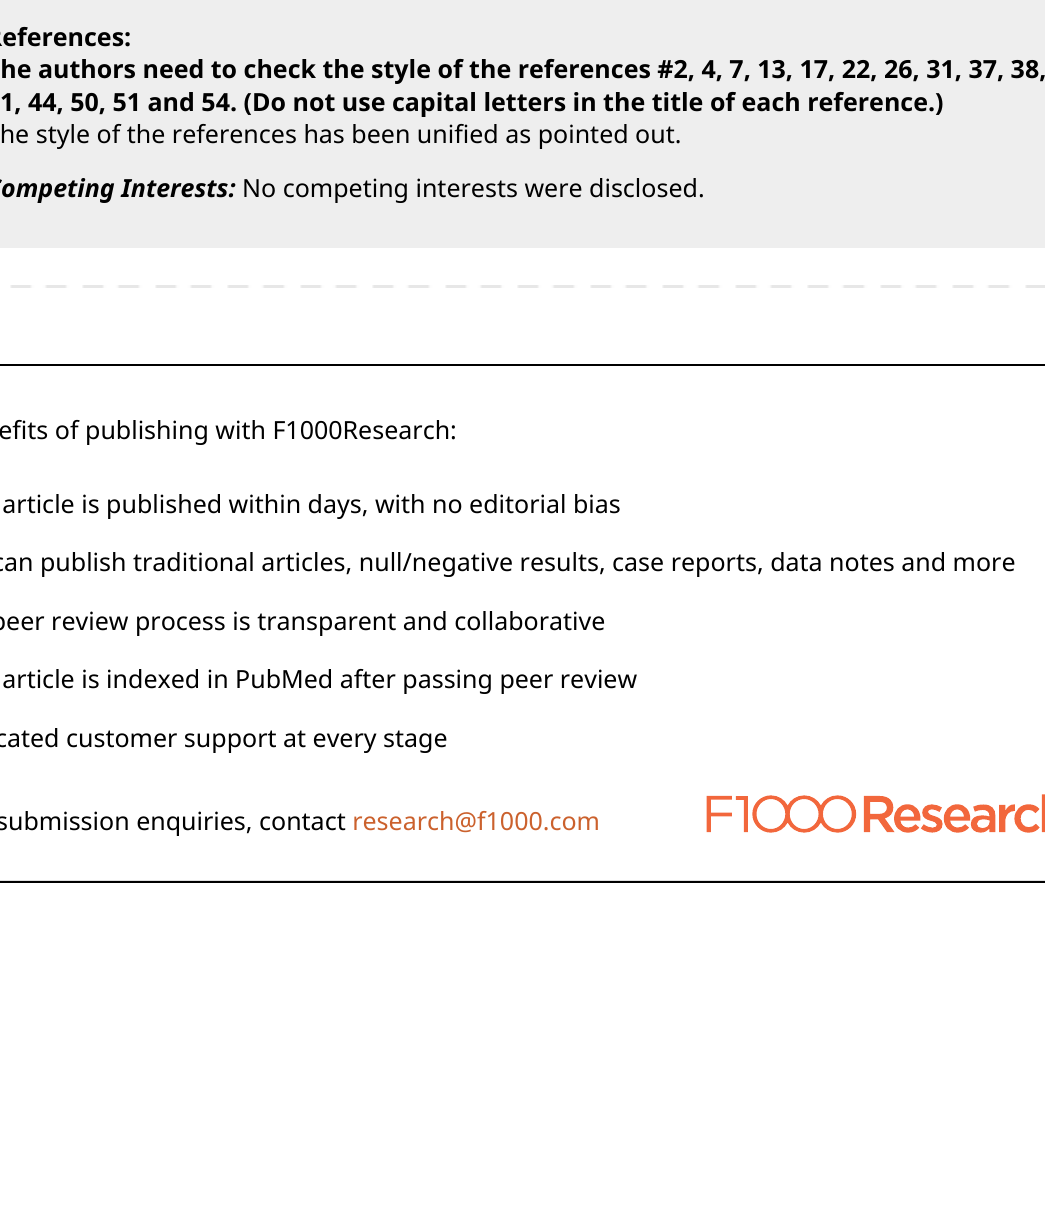
Figure 4(a): The authors need to check the figure. Absconditabacteria? The problem of the left edge of the figure being cut off has been